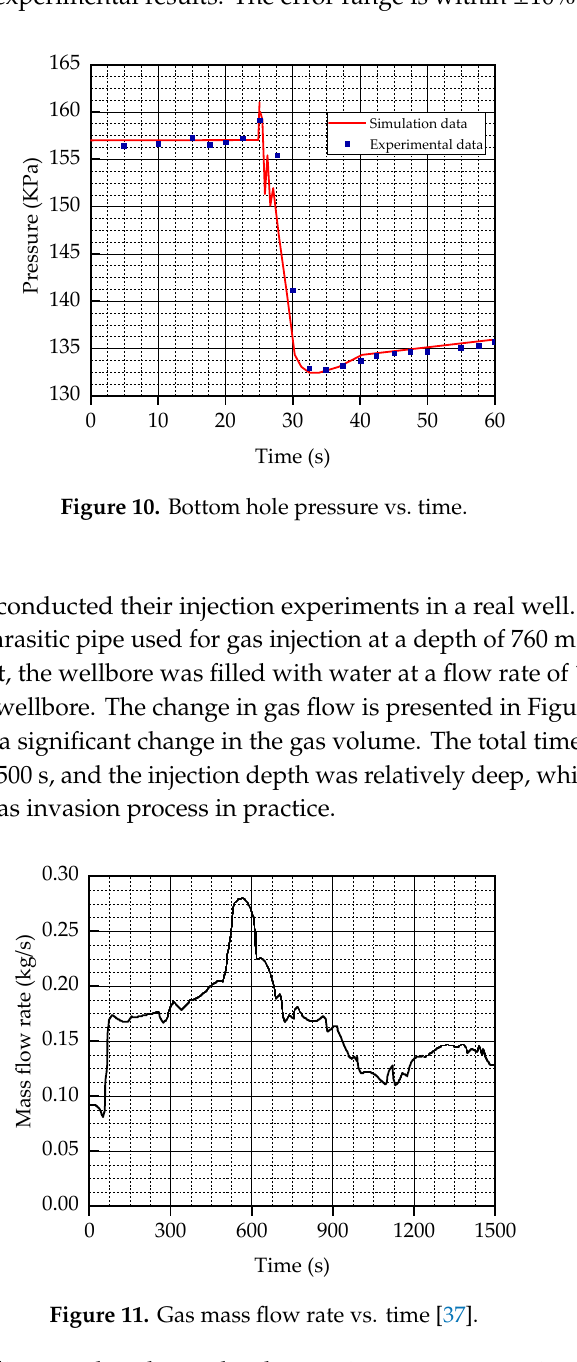
Figure 9. Experimental test.